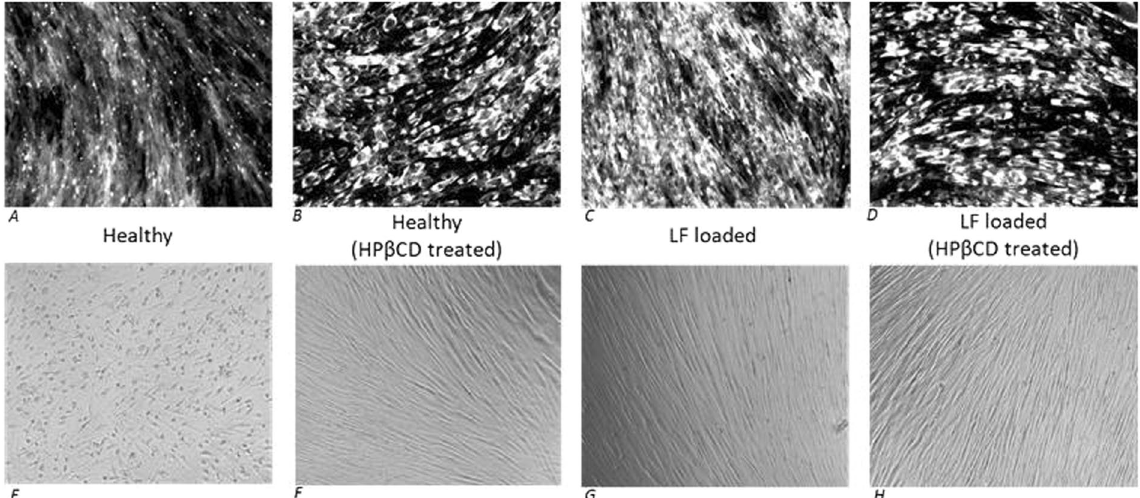
Figure 2. Long term HP β CD treatment increases cellular cholesterol. ( Top Row ) - Filipin staining shows HP β CD treatment, LF loading and the two combined each cause substantial cellular cholesterol increase relative to healthy cells. ( Bottom Row ) Cells with increased lysosome cholesterol composition are more resistant to apoptosis induced by the lysomotropic agent MSDH. Healthy confluent cells were killed by MSDH exposure (45 uM MSDH for 42 hours) while HP β CD treated cells and LF loaded cells survived with no signs of visual stress. Therefore, HP β CD and LF modulate lysosome membrane cholesterol composition in a manner consistent with that suggested by filipin staining.